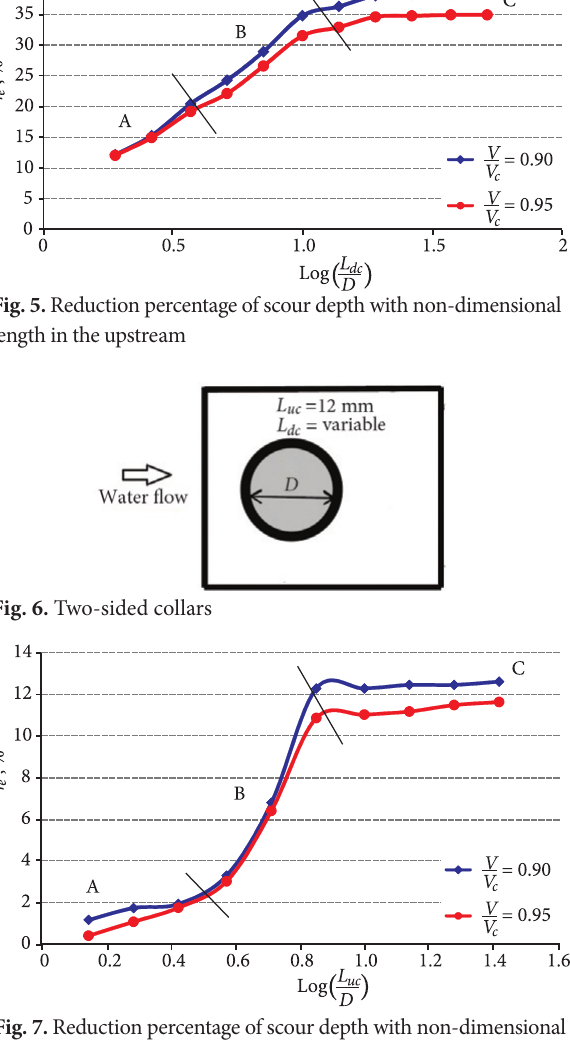
Fig. 7. Reduction percentage of scour depth with non-dimensional length in the